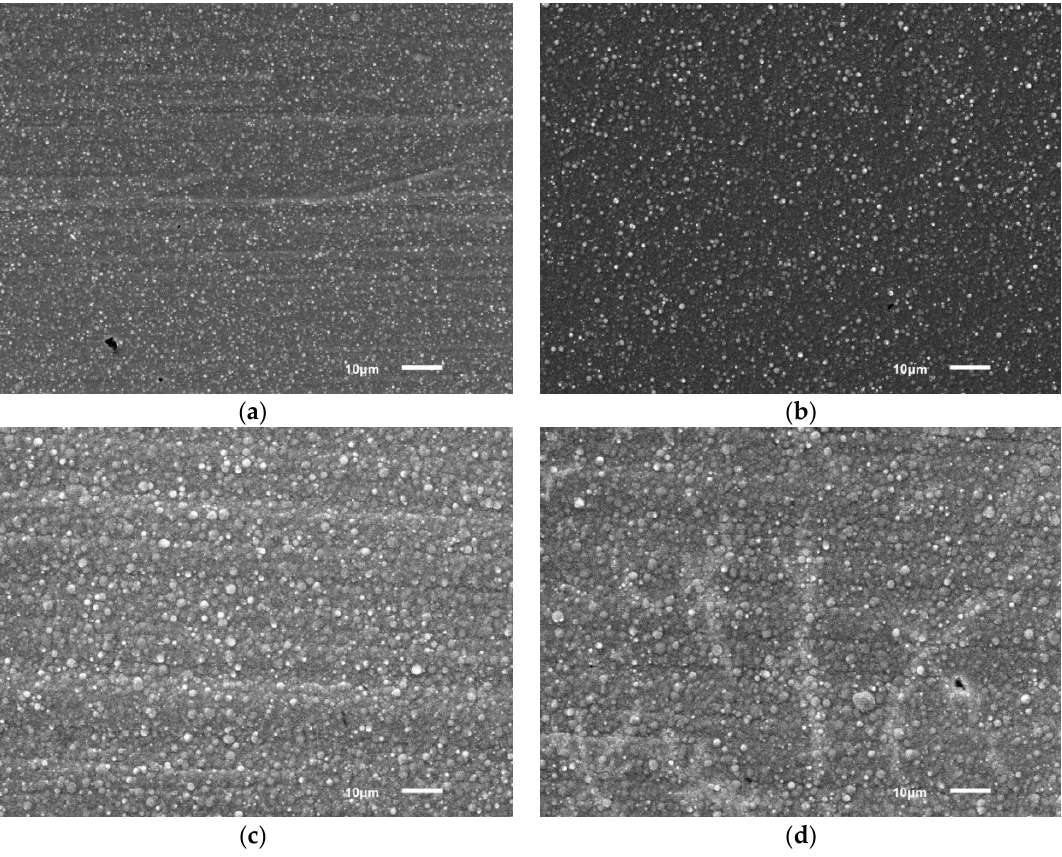
Figure 5. SEM images of Ni–W coatings of a 5 μ m in thickness made in electrolytes with pH 9.5 in the PC mode with different current densities, A·cm − 2 : ( a ) 0.01, ( b ) 0.02, ( c ) 0.05, ( d ) 0.1.